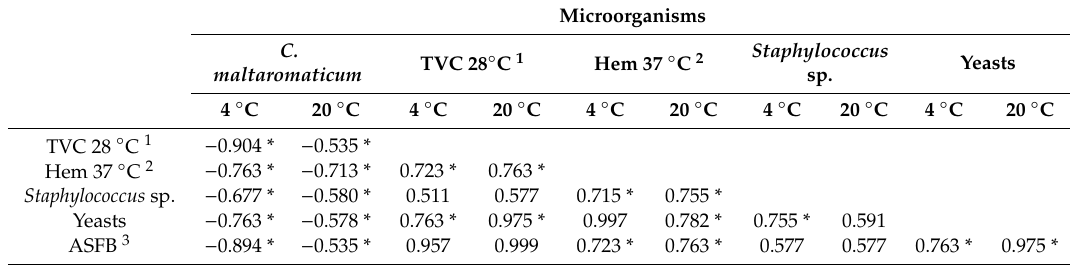
Table 2. The values of correlation coe ffi cients between microbial counts in feed supplemented with 20% amaranth meal and C. maltaromaticum probiotic bacteria (ACF) stored at 4 and 20 ◦ C. The correlations between microbial counts in ACF 4 ◦ C (N = 14) and ACF 20 ◦ C (N = 14) samples were analyzed with Spearman’s test.